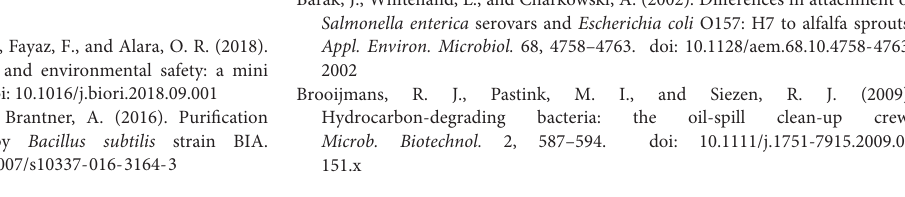
FIGURE S2 | Assays for Biosurfactant production. Examples of different physical assays are displayed for the (A) Oil spreading assay, (B) CTAB agar assay, (C) Emulsification capacity assay, (D) Blood agar plate and (E) Drop collapse assay, with left to right denoting negative, positive and four test samples (S1–S4). (F) Microplate assay; from left to right displaying negative, positive controls and a test sample (S1). TABLE S1 | Source of organisms used in the study. TABLE S2 | Antagonistic activity of OB9 cultures against bacteria and